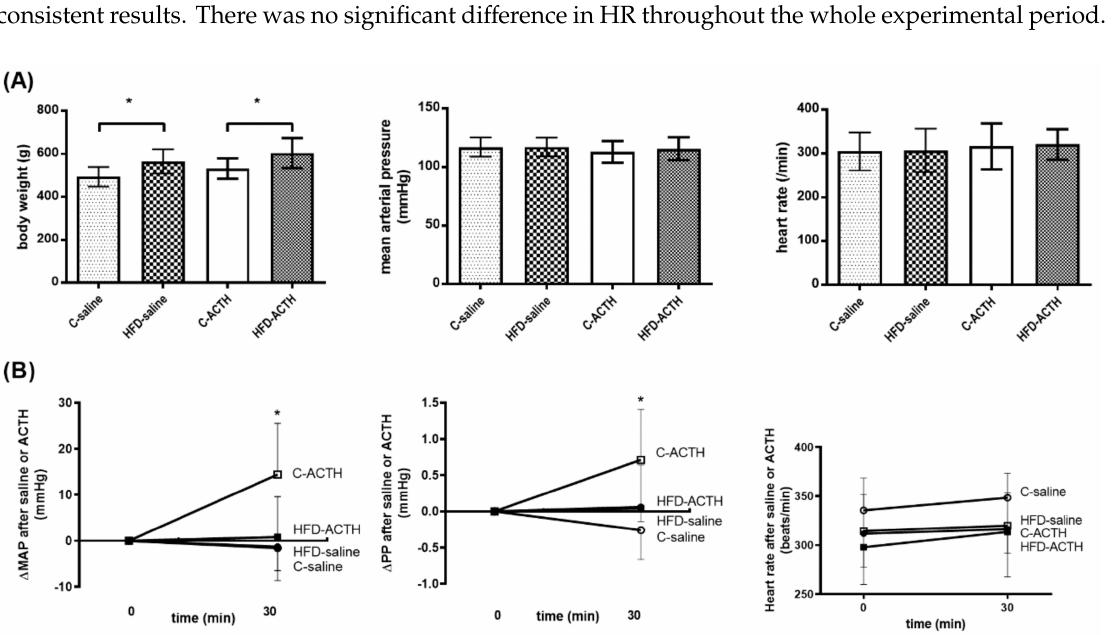
Figure 6. The hemodynamic response to adrenocorticotropic. hormone (ACTH) injection after LPS-induced septic shock. ( A ) The BW was significantly higher in HFD group. The MAP and HR was not significantly di ff erent among the four groups. ( B ) The ACTH or saline (served as vehicle) were given 120 min after LPS. The MAP increased significantly in C-ACTH group as compared to C-saline group at 30 min after ACTH injection ( t -test). However, ACTH had no e ff ect in HFD group. The